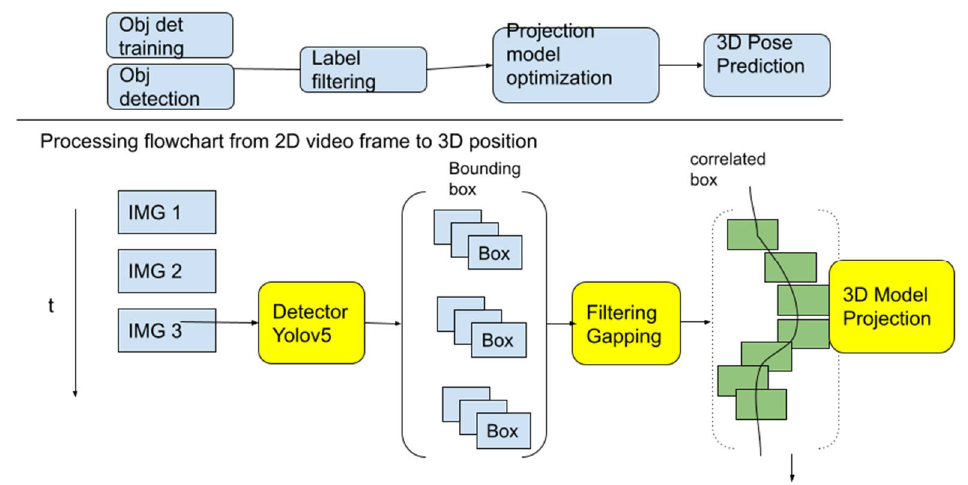
Figure 2. Processing flowchart to extract 3D pose from video frames. The three main computing modules are shown in yellow boxes.